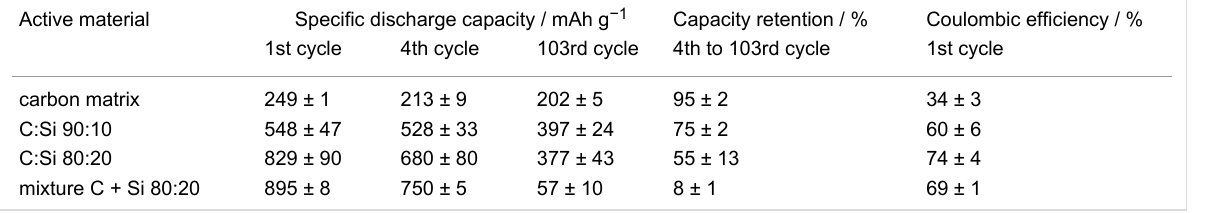
Table 1: Overview of the specific discharge (=delithiation) capacities, capacity retention and first cycle Coulombic efficiencies of the different samples during the long-term cycling investigations. Active